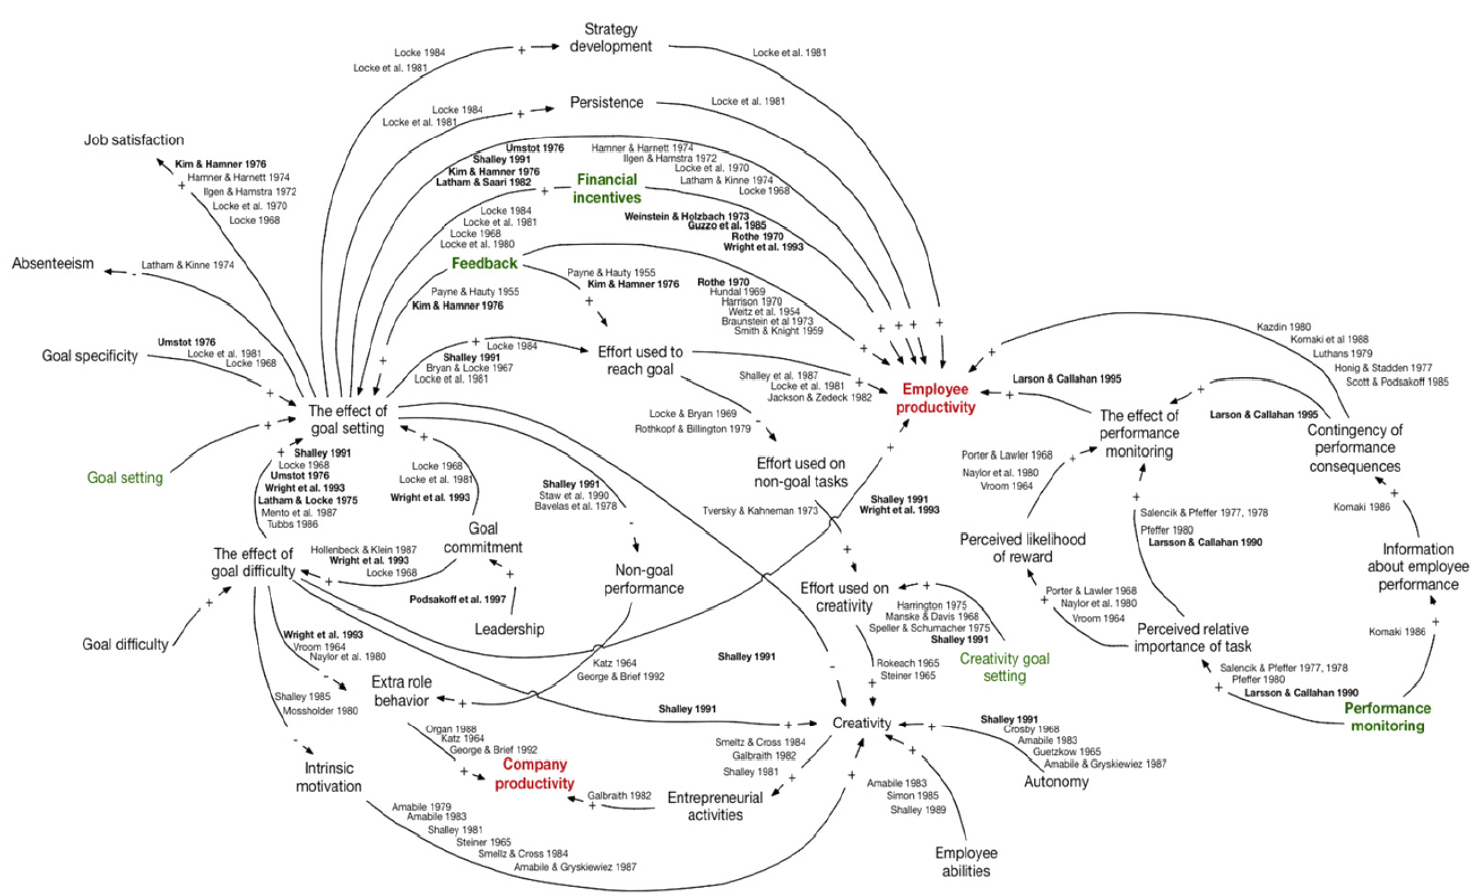
Figure 6. Motivation CLD from synthesis step